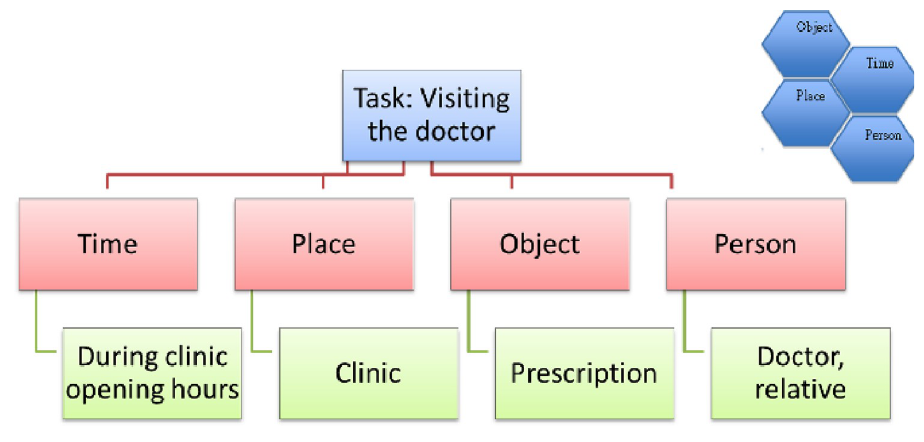
Fig 2. Example using the honeycomb